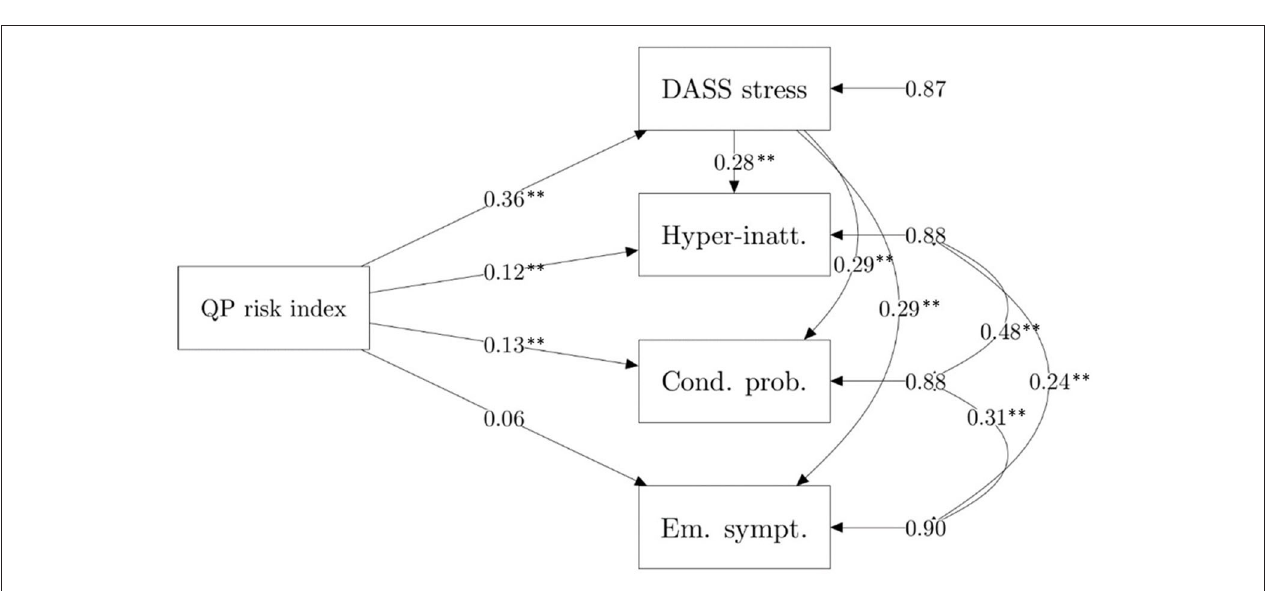
associated with parents’ and children’s psychological